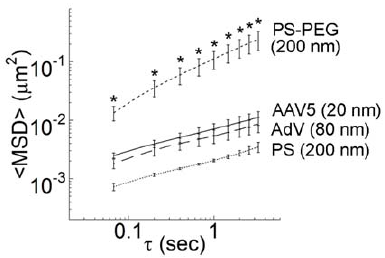
Figure 4. Transport mode distributions of AdV, AAV5, PS and PS-PEG particles. Particles were classified into either (i) immobile or hindered and (ii) diffusive [12,15–17]. *Statistically significant difference when compared with AAV5, AdV or PS within the same transport mode classification (p , 0.05).